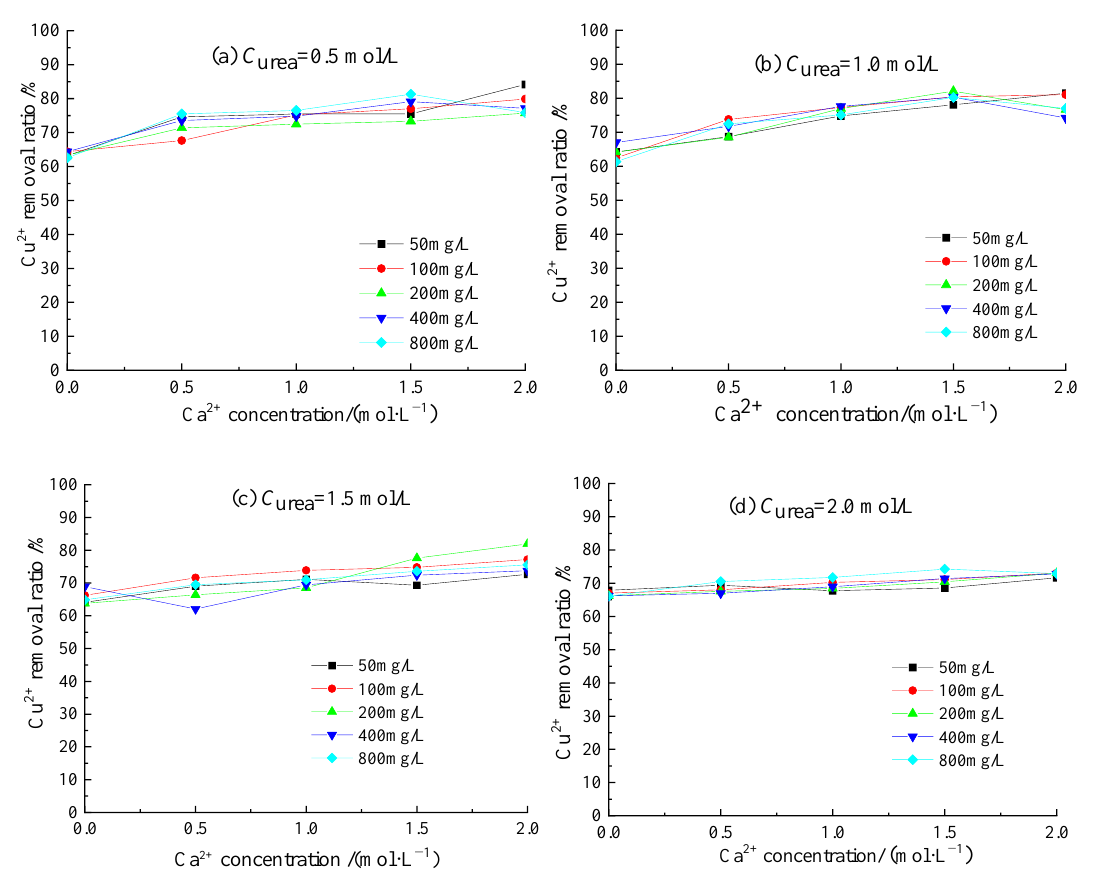
Figure 6. Removal ratio of Cu 2+ with different urea concentrations (( a ) C urea = 0.5 mol/L; ( b ) C urea = 1.0 mol/L; ( c ) C urea = 1.5 mol/L; ( d ) C urea = 2.0 mol/L).